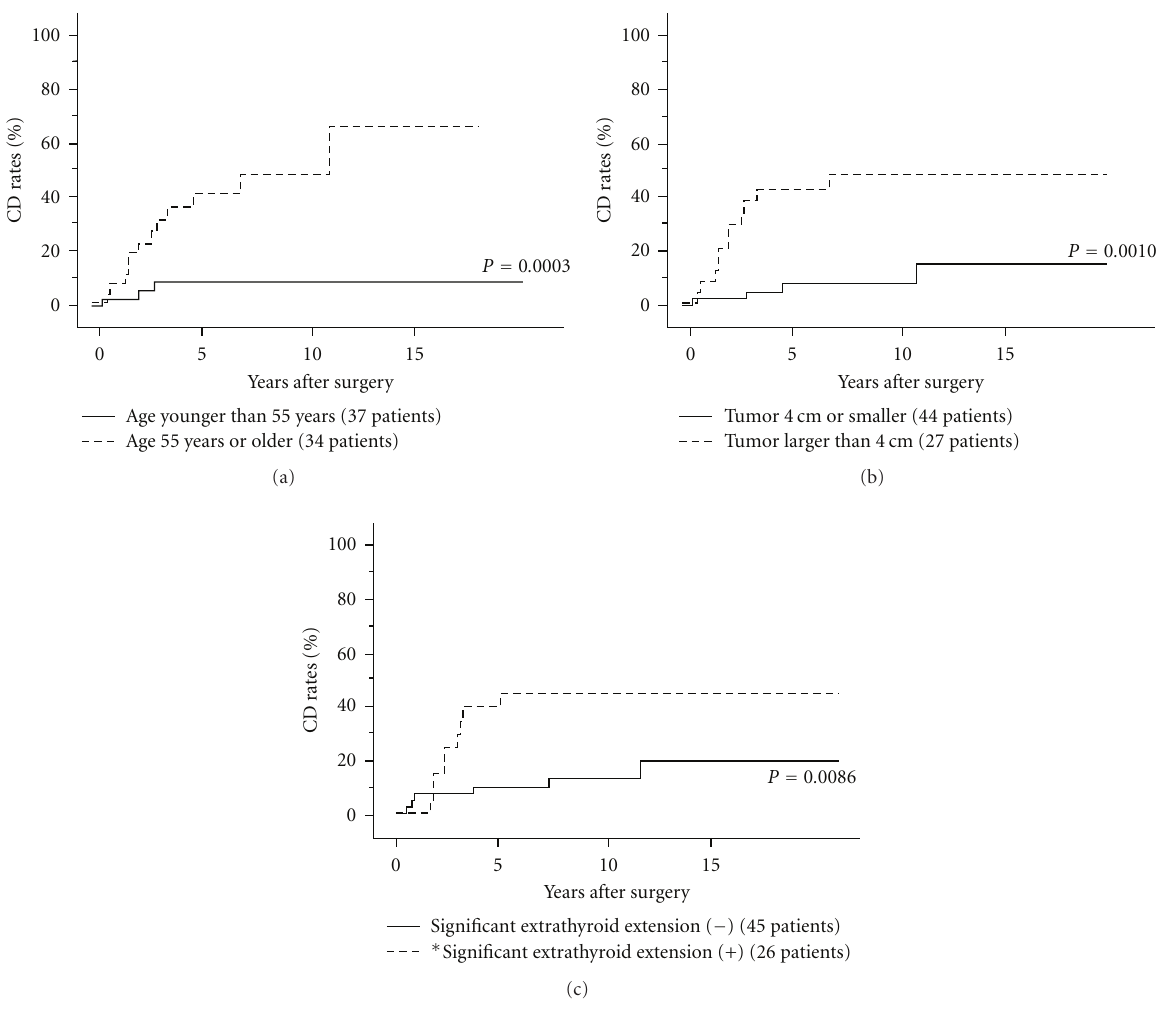
Figure 7: (a) CD rates of M1 patients with PTC aged 55 years or older and those aged younger than 55 years. (b) CD rates of M1 patients with PTC having tumor 4cm or smaller and those having tumor larger than 4cm. (c) CD rates of M1 PTC patients with and without extrathyroid extension. ∗ Except for recurrent laryngeal nerve and cricothyroid or inferior constrictor